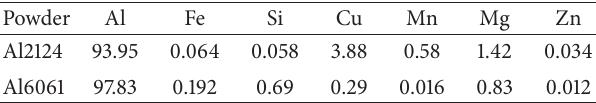
Table 1: Composition of Al2124 and Al6061